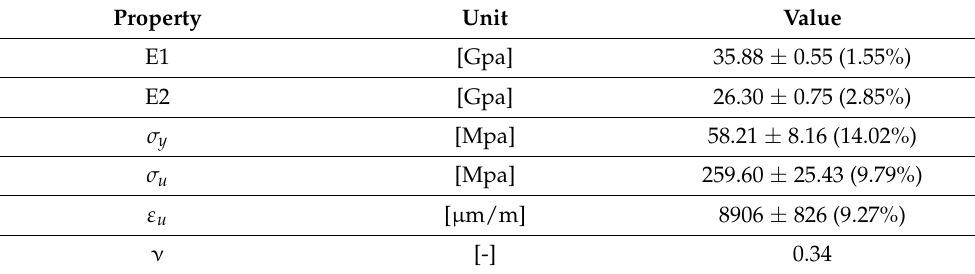
Table 3. Calculated mechanical properties of the flax fiber—epoxy resin composite.